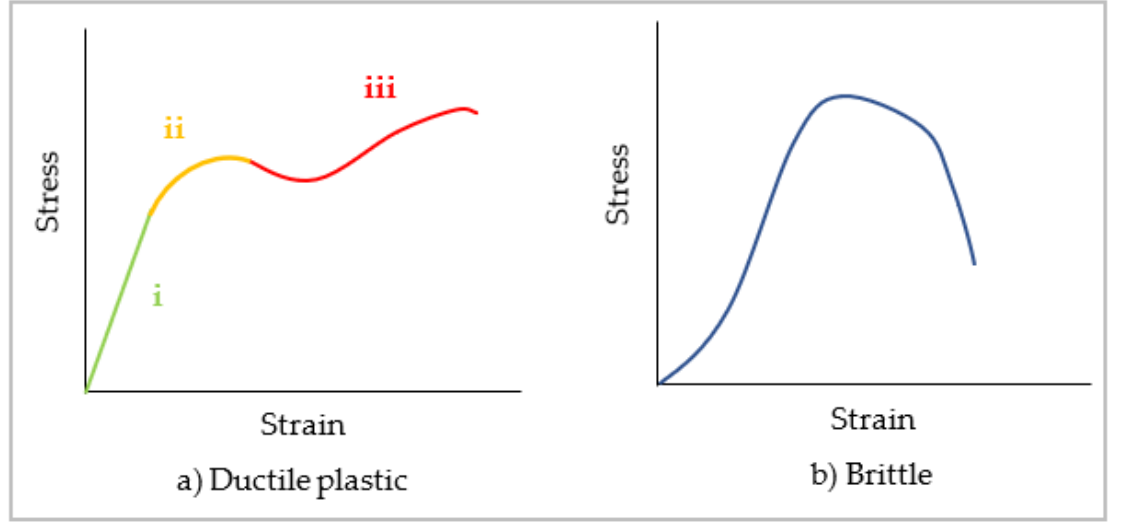
Figure 5. Normalised compressive stress–strain responses ( a ) Ductile, ( b ) Brittle.